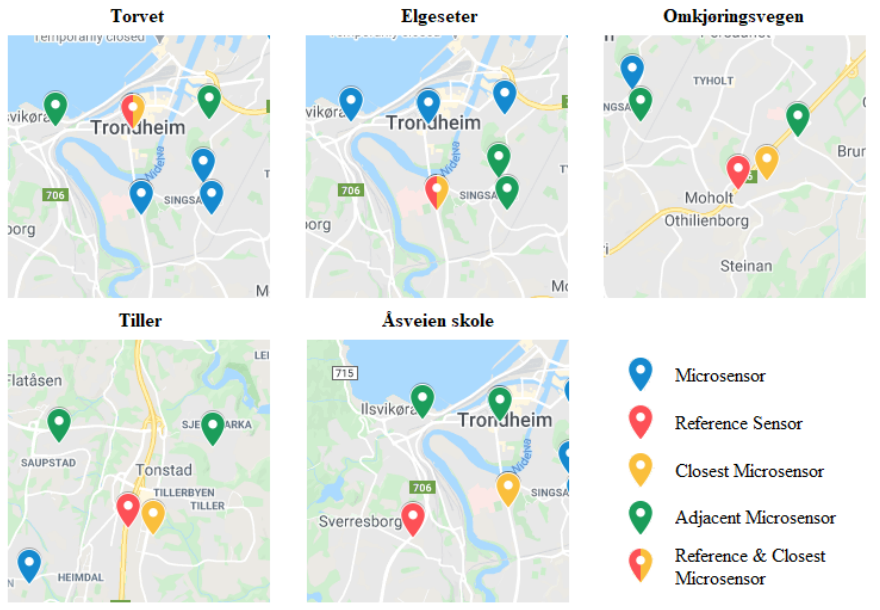
Figure 7. Adjacent low-cost sensors used in the baseline models for every reference sensor. Red : reference sensors. Green : two of the three closest adjacent low-cost sensors used in the average value baseline model. Yellow : the third and closest adjacent low-cost sensor used both in the average value and closest low-cost sensor baseline models. Red/Yellow : in the Torget and Elgeseter areas there is a low-cost sensor next to the reference sensor, so a dual coloring is used to mark